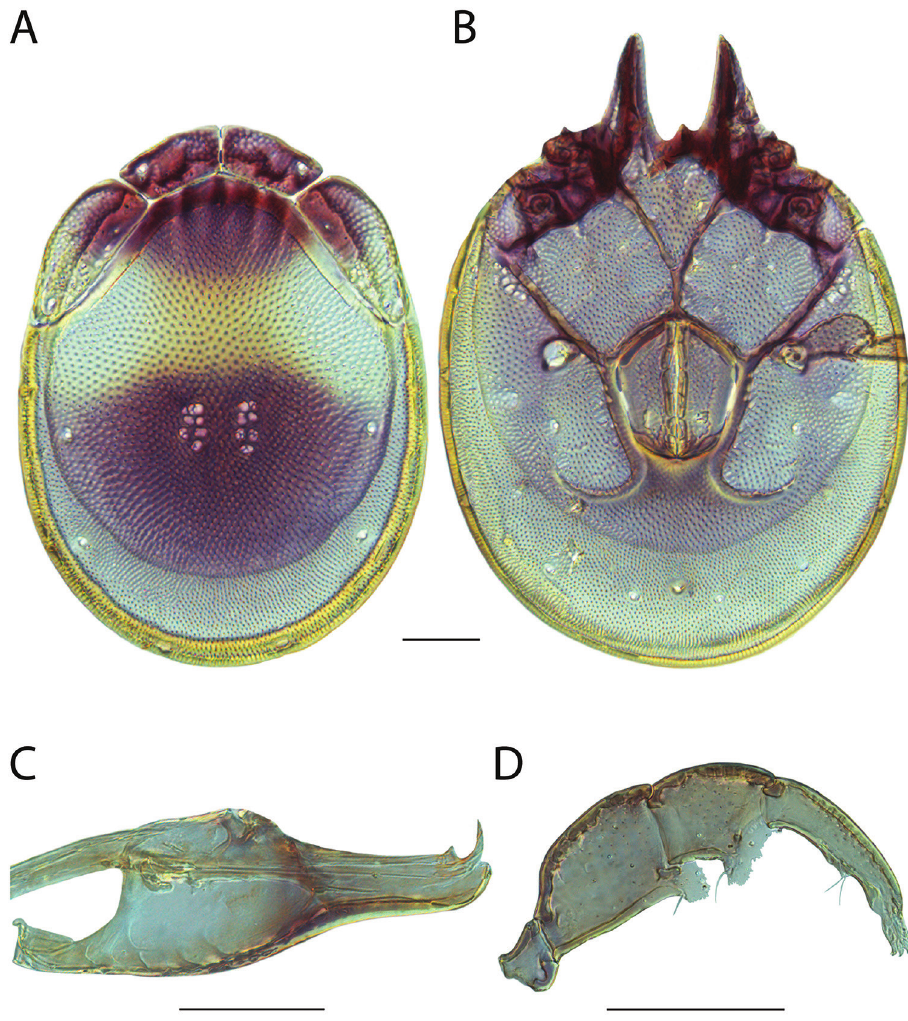
Figure 22. Torrenticola arktonyx sp. n. female: A dorsal plates B venter (legs removed) C subcapitulum D pedipalp (setae not accurately depicted). Scale = 100